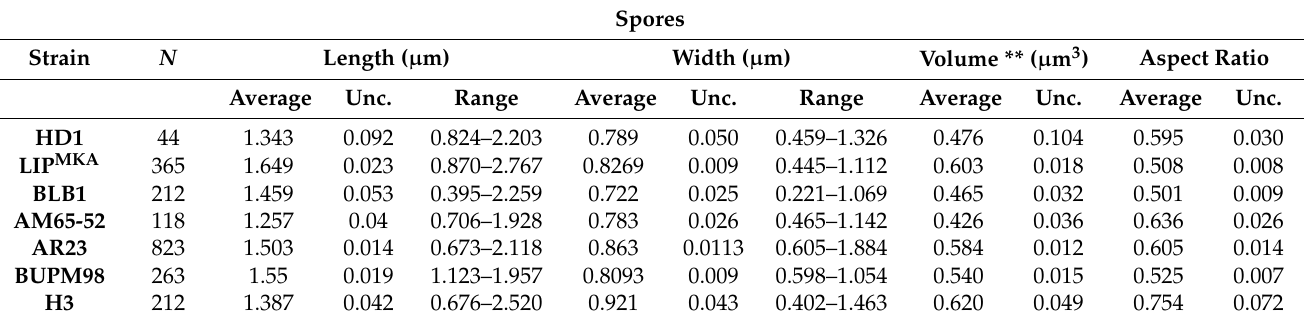
Table 4. Morphological data of spores produced by the seven chosen Bacillus thuringiensis strains for N measurements.